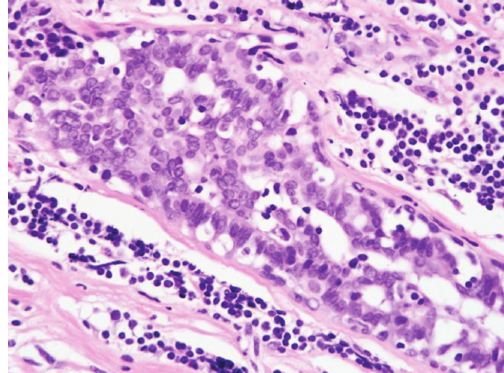
Figure 5: High magnification of the tumor ( × 400). Small lympho- cytes infiltrated between ductal epithelia forming lymphoepithelial